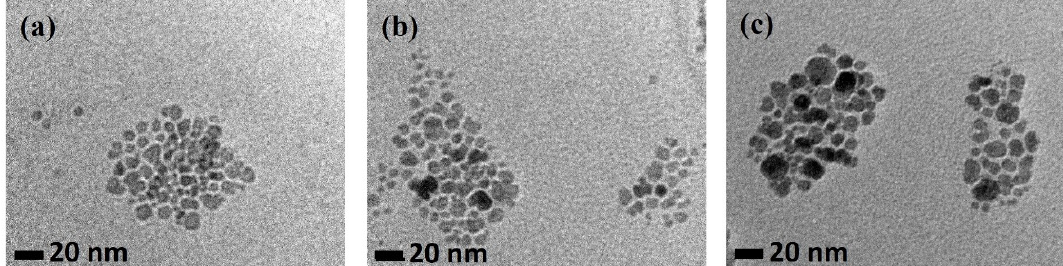
Figure 2. TEM images for samples ( a ) OA@NP, ( b ) LA@NP, and ( c ) MA@NP. Table 1. Mean particle diameter 𝑑 (cid:3021)(cid:3006)(cid:3014) by TEM and its standard deviation σ ; average crystallite size 𝑑 (cid:3025)(cid:3019)(cid:3005) and its uncertainty, magnetic diameter 𝑑 (cid:3014)(cid:3002)(cid:3008) from the Langevin equation and its standard deviation σ , hydrodynamic diameter 𝑑 (cid:3005)(cid:3013)(cid:3020) , and its polydispersity index (PDI) and ζ